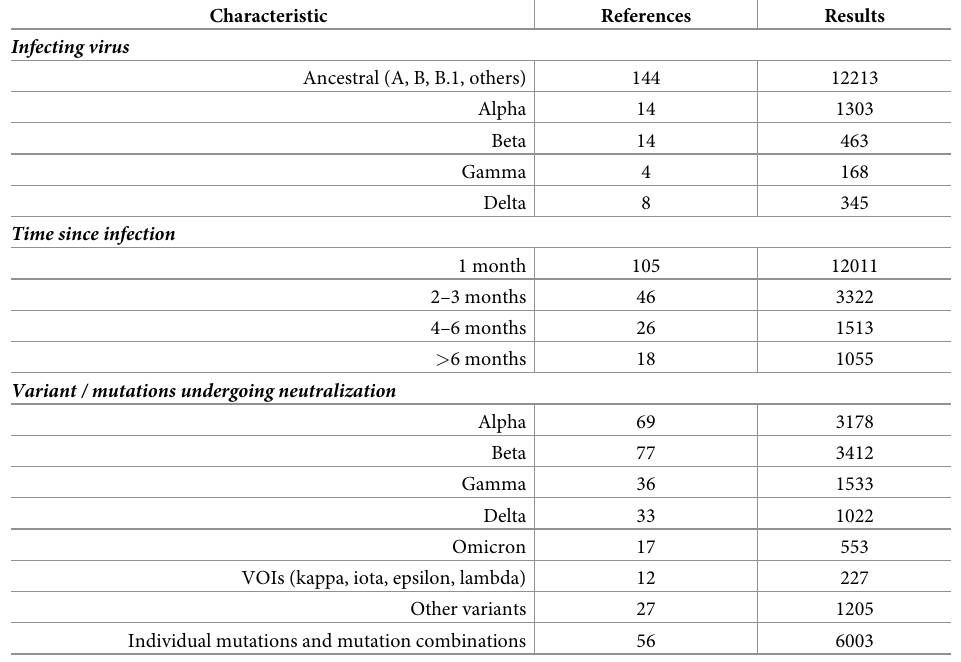
Table 5. Numbers of Convalescent Plasma (CP) neutralization experiments in CoV-RDB according to the infect- ing virus, time since infection, and SARS-CoV-2 variant tested.